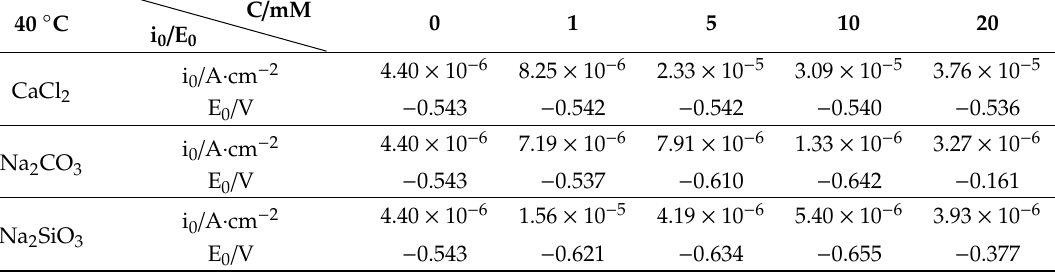
Table 3. Electrochemical parameters obtained from the fitted